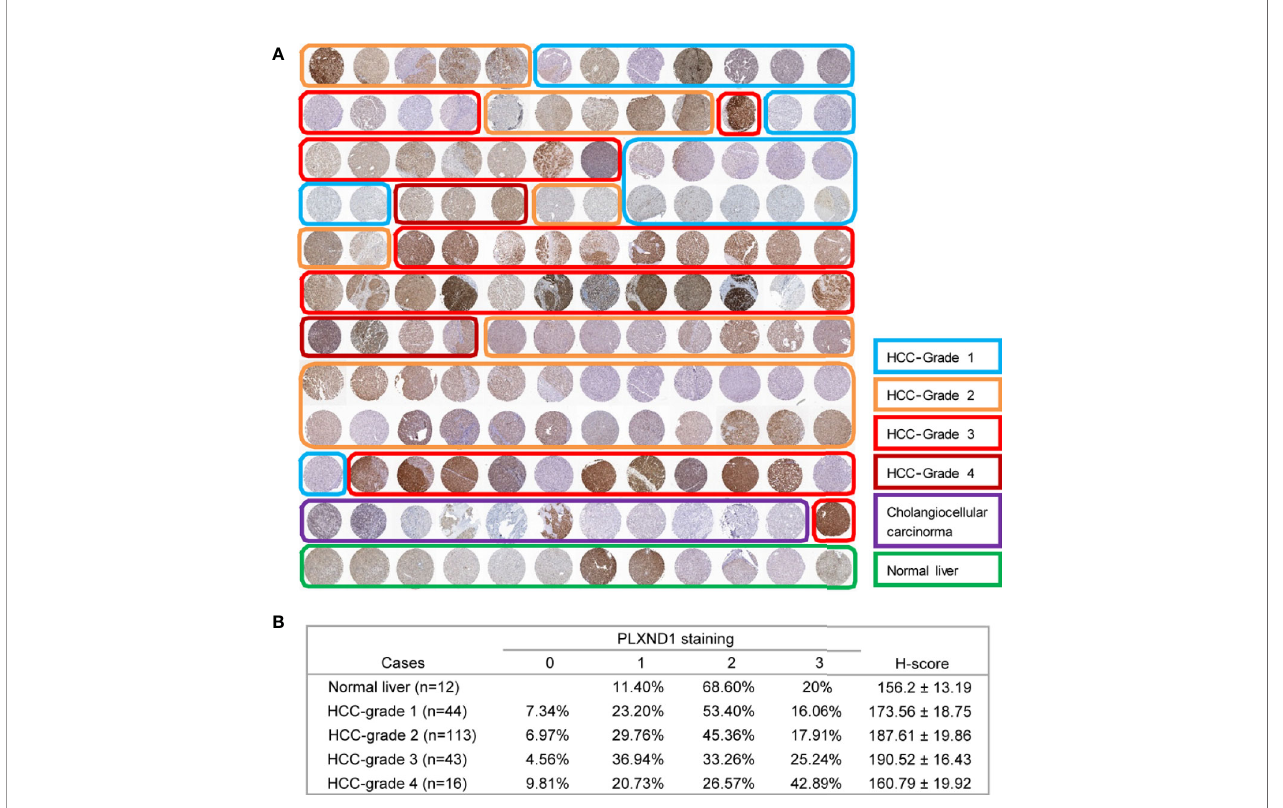
FIGURE 2 | The expression of PLXND1 protein in hepatocellular carcinoma (HCC). (A) Tissue microarrays of HCC tumor tissues as well as normal liver tissues were stained for PLXND1 protein. (B) PLXND1 signal intensities in normal liver tissues versus different grades of HCC tissues were quanti fi ed by H-scores, H-score mean ± SD was showed. Blue square, well-differentiated HCC (grade 1); orange square, moderately differentiated HCC (grade 2); red square, poorly differentiated HCC (grade 3); purple square, undifferentiated HCC (grade 4); green square, normal liver. The normal liver tissues were the adjacent normal liver tissues from hepatic hemangioma and distributed in the bottom row of tissue microarray. The HCC tumor tissues were randomly distributed in the upper part of tissue microarray. All these tissues were embedded in the same paraf fi n